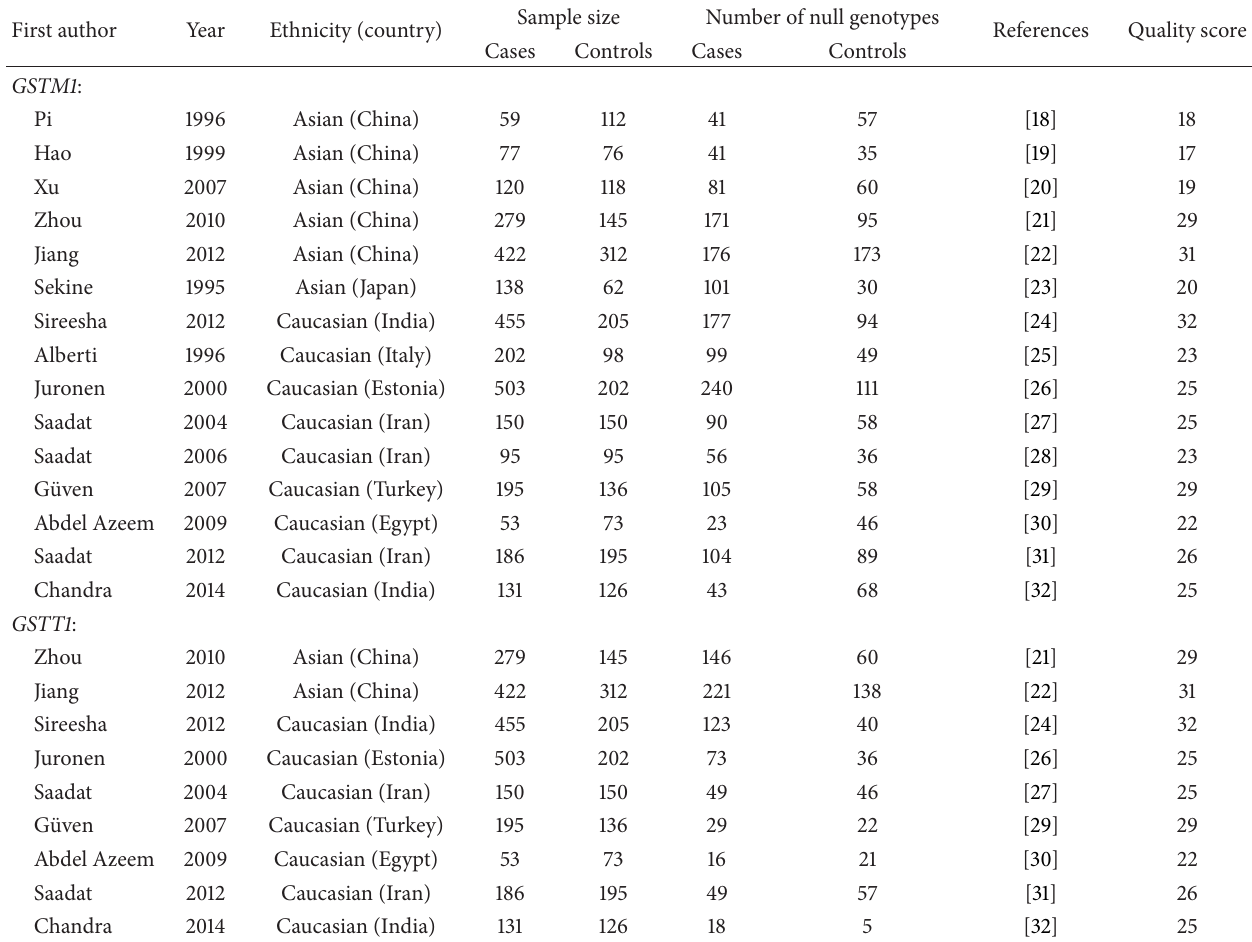
Table 1: Characteristics of studies included in the